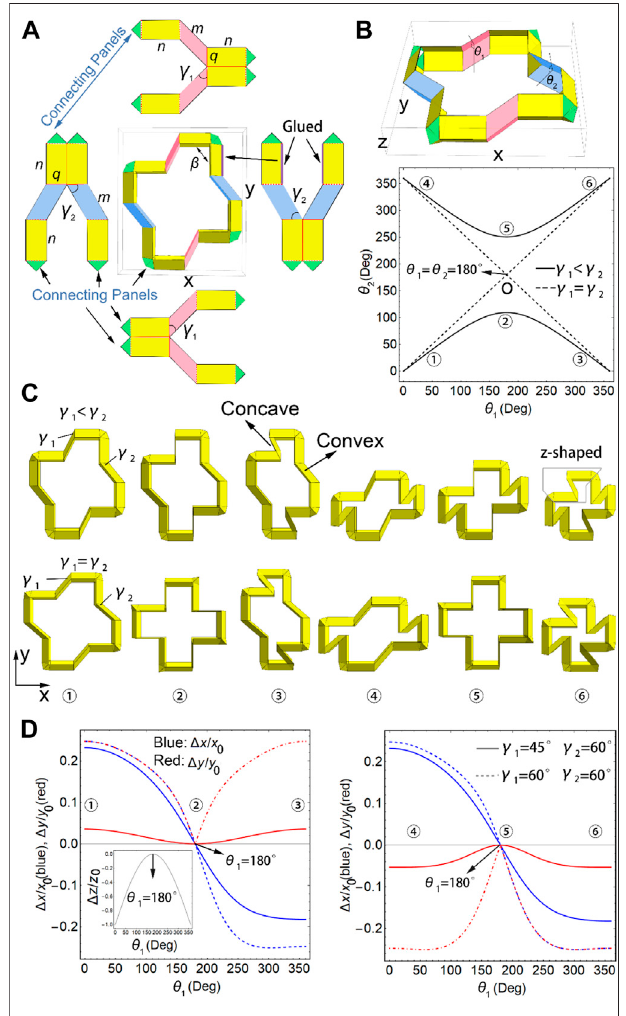
FIGURE 1 | Ring-like unit design. (A) Ring-like unit comprising four “ z ” - shaped structures with their 2D folding patterns and lengths ( m , n , and q ) and their angle parameters ( γ 1 and γ 2 ) . (B) De fi nition of the deformation angles θ 1 and θ 2 and their relations (in deformation paths, ① → ② → ③ and ④ → ⑤ → ⑥ ) for γ < γ γ (cid:1) γ fi gurations ① ~ ⑥ . 1 2 and 1 2 . (C) Structural con (D) Nominal strains Δ x (blue lines) and Δ y (red lines) as functions of the y 0 x 0 deformation angle θ 1 with γ 1 (cid:1) γ 2 (cid:1) 60 ° (nonsolid lines, including blue dashed and red dot – dashed lines) and γ 1 (cid:1) 45 ° and γ 2 (cid:1) 60 ° (solid lines). Inset, nominal strains Δ z as a function of θ 1 . For all units here, β (cid:1) 90 ° z 0